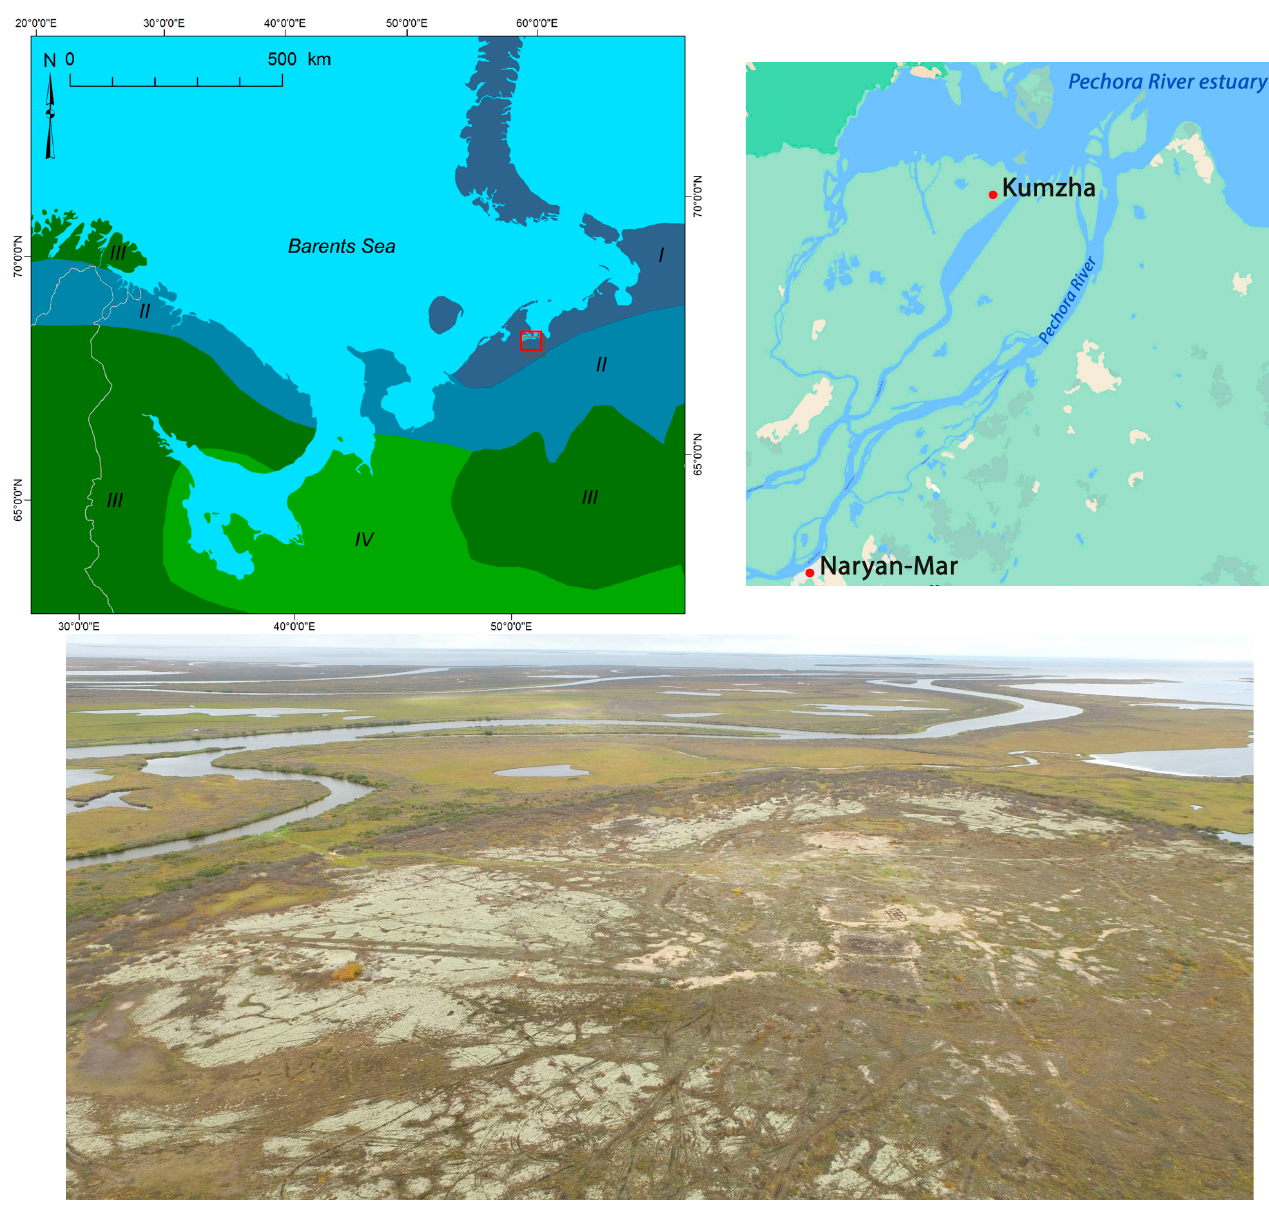
Figure 1. Location of study area in relation to the European mire regions, the Pechora River delta, marked with the red frame, and a general view of the site from the quadcopter. The European mire regions are given according to [20], as simplified from [21]: I—Arctic seepage and polygon mire region, II—palsa mire region, III—northern fen region, IV—typical raised bog region.